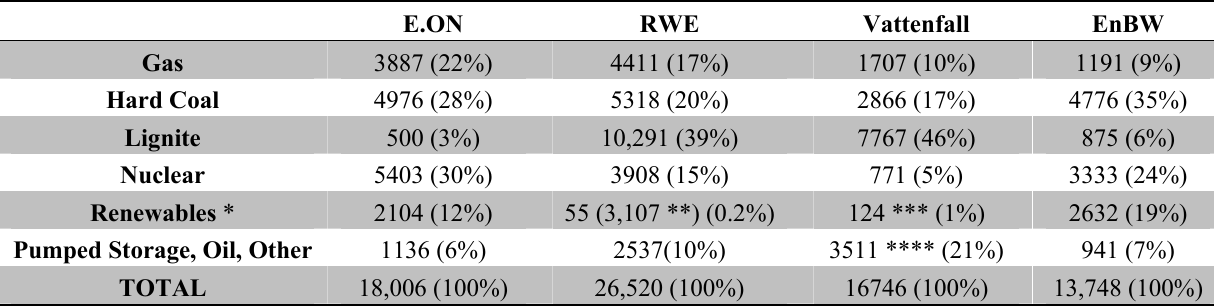
Table 4. Power Plant Capacity of the four German companies [48–51].